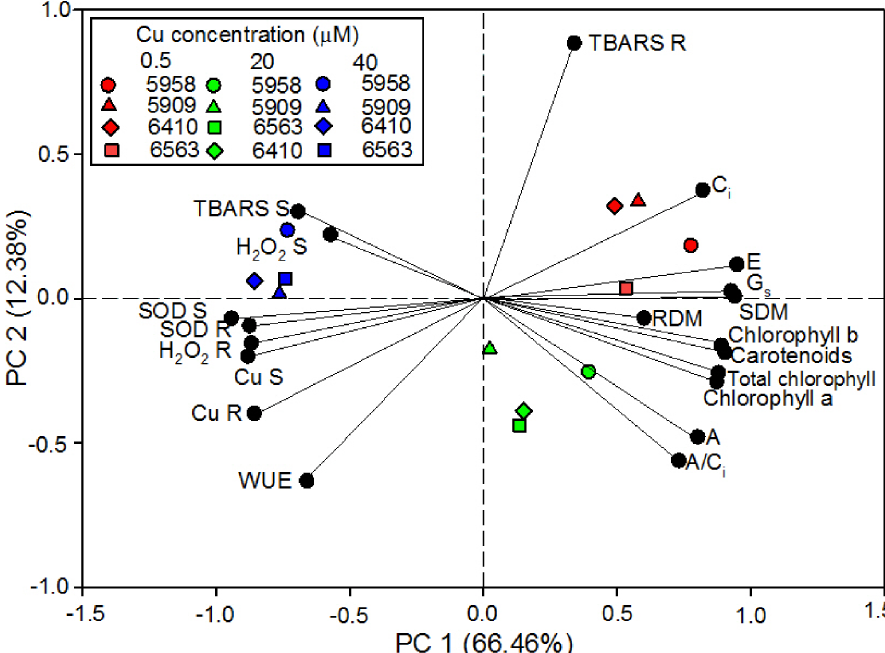
Figure 4 - Relationship between principal component 1 (PC1) and principal component 2 (PC2) in the variables such as groups of photosynthetic parameters (A, A/C , C , E, G and WUE), photosynthetic i i s pigments (chlorophyll a, chlorophyll b, total chlorophyll and carotenoids) shoot dry mass (SDM), root dry mass (RDM), Cu concentration in shoots and roots (Cu S and Cu R), enzymatic activity of superoxide dismutase in shoots and roots (SOD S and SOD R), hydrogen peroxide concentration in shoots and roots (H O S and H O R) and lipid peroxidation in shoots and roots (TBARS S and 2 2 2 2 TBARS R) in the four soybean cultivars (5909, 5958, 6410 and 6563) subjected to different Cu concentrations in nutrient solution (0.5, 20 and 40